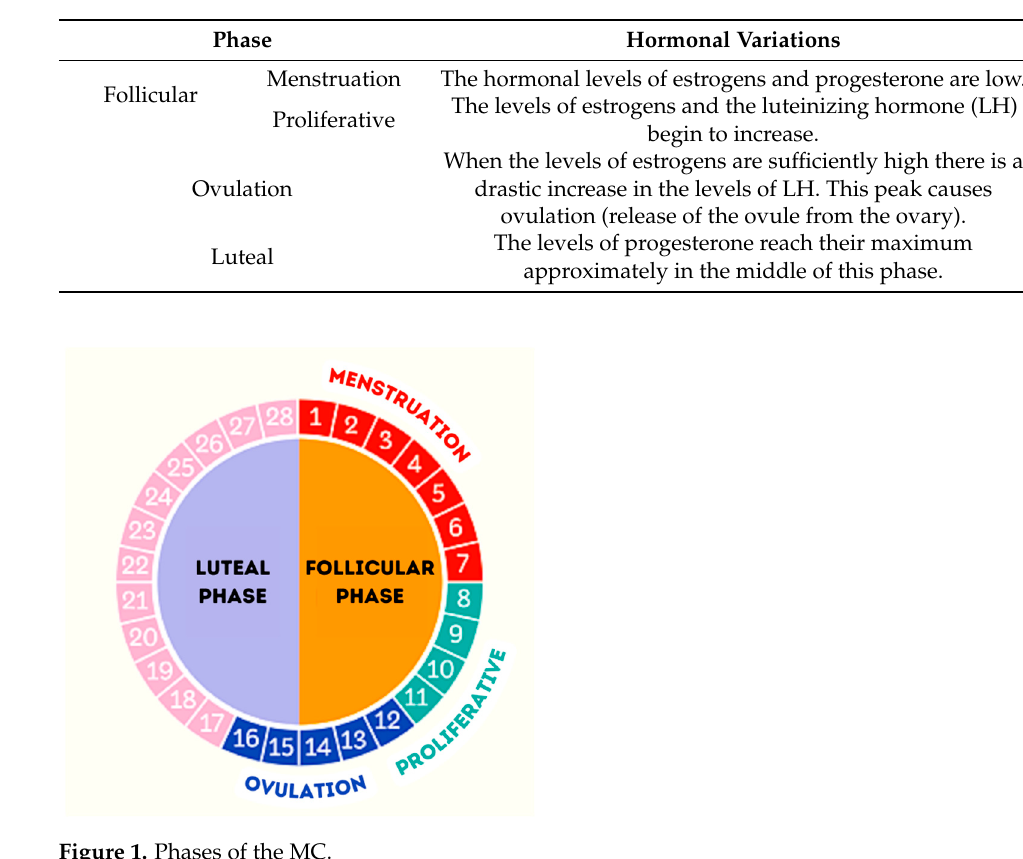
Table 1. Phases of the MC and main hormonal variations.